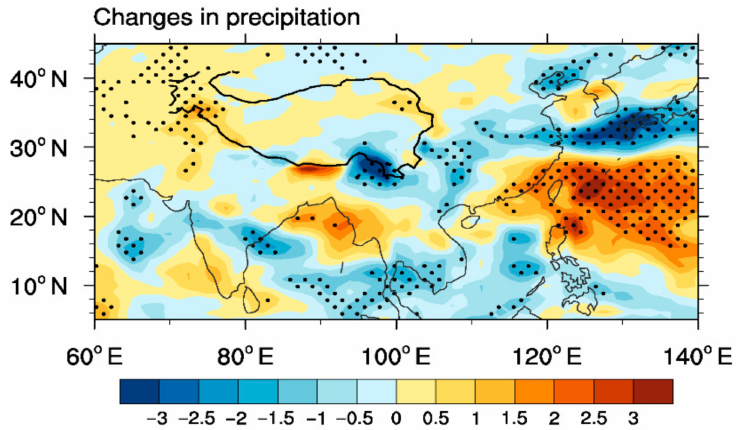
Figure 12. Changes in precipitation rate (mm / day) over the TP. The dots denote the changes in precipitation that are significant above the 90% confidence